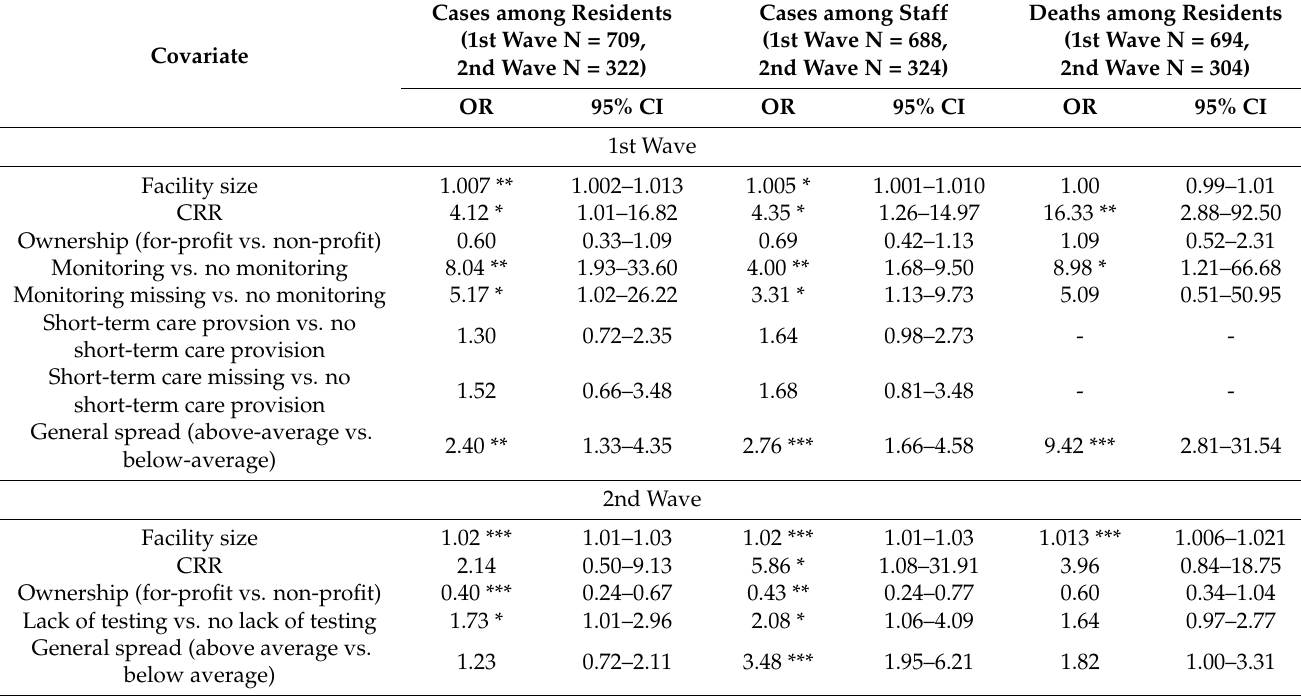
Table 3. Zero models